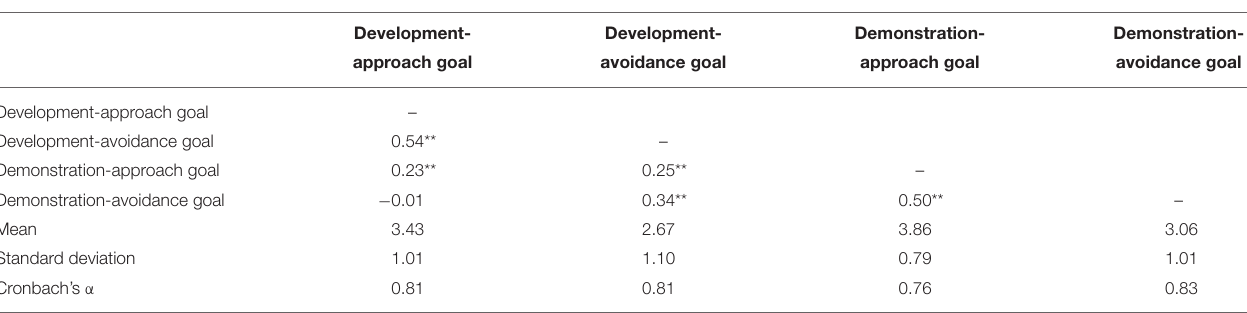
TABLE 1 | Study 1: Intercorrelations and descriptive